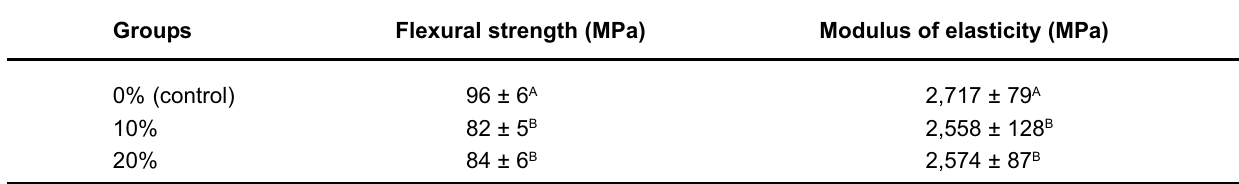
Means followed by the same uppercase letters in columns are not significantly different (one-way ANOVA and Tukey HSD post hoc test; α